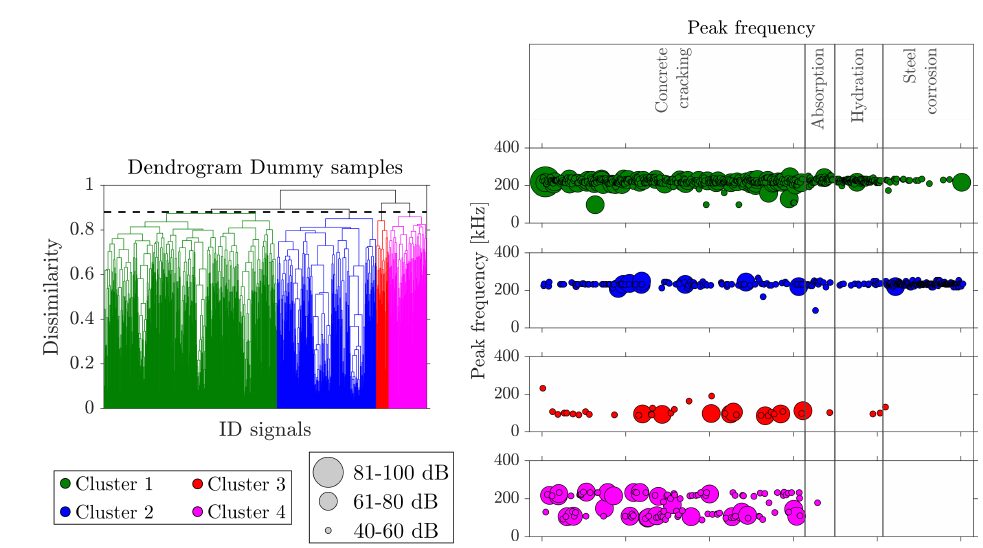
Figure 4. Results of the clustering algorithm performed on dummy samples with ( left ) dendrogram, and ( right ) peak frequency versus ID number of the AE signal. The size of the dots depends on the amplitude (in dB) of the AE signal. Expected AE sources are indicated for each group of signal IDs.